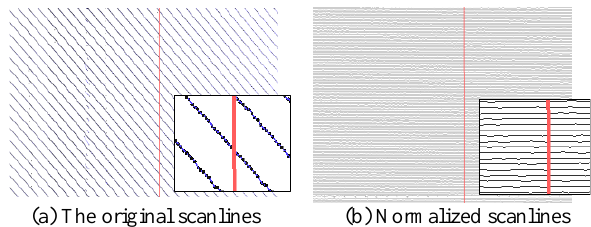
Figure 3. The original scanlines and normalized